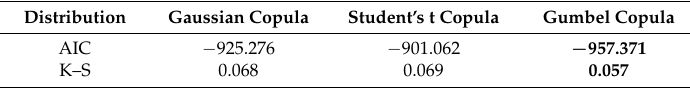
Table 6. Fitting results of bivariate distribution functions. AIC, Akaike information criterion.